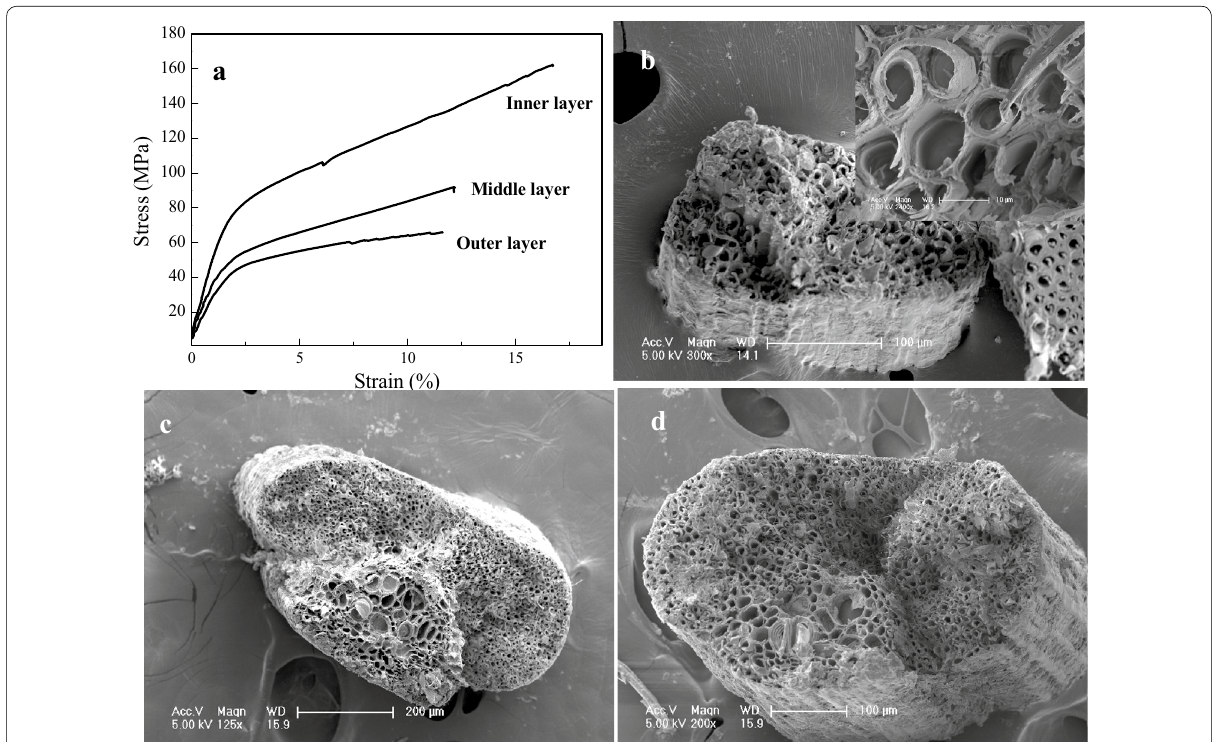
Fig. 4 a Typical stress–strain curves of windmill palm fibers in different layers; fracture surface of fiber in b inner, c middle, and d outer layer of one windmill palm leaf